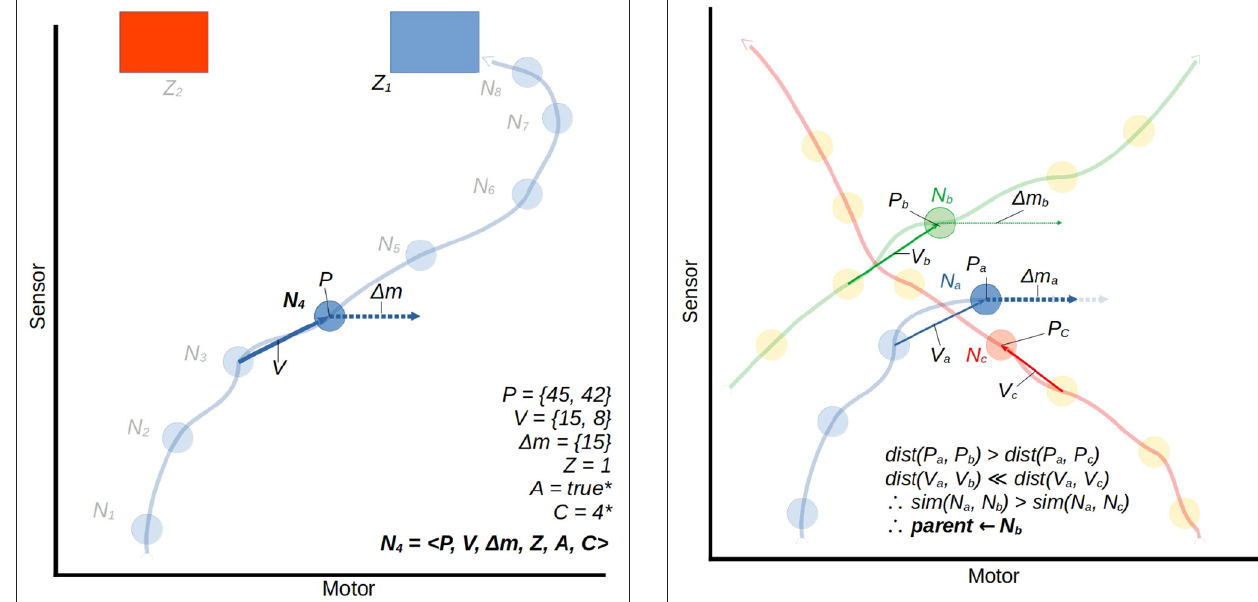
FIGURE 6 | A trajectory through a 2D sensorimotor space, represented in an ASM-unit with eight nodes. We use the node N 4 as an arbitrary example, all others share the same properties. For illustrative purposes we treat the motor and sensor dimensions abstractly as continuous ranges between 0 and 100. Note that the component A = 1 is determined in the context of subsequent activations of other ASM-units. This is explained in Section 2.4.